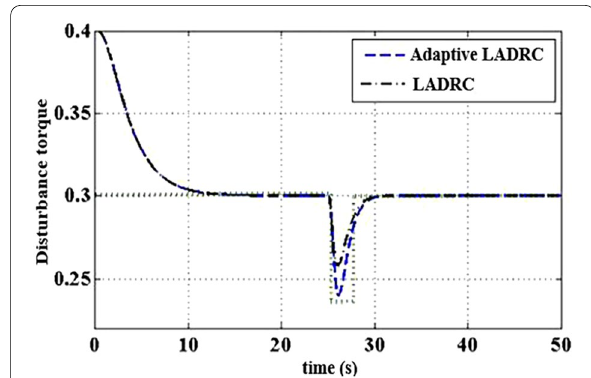
Figure 10 Pulse disturbances of the controllers